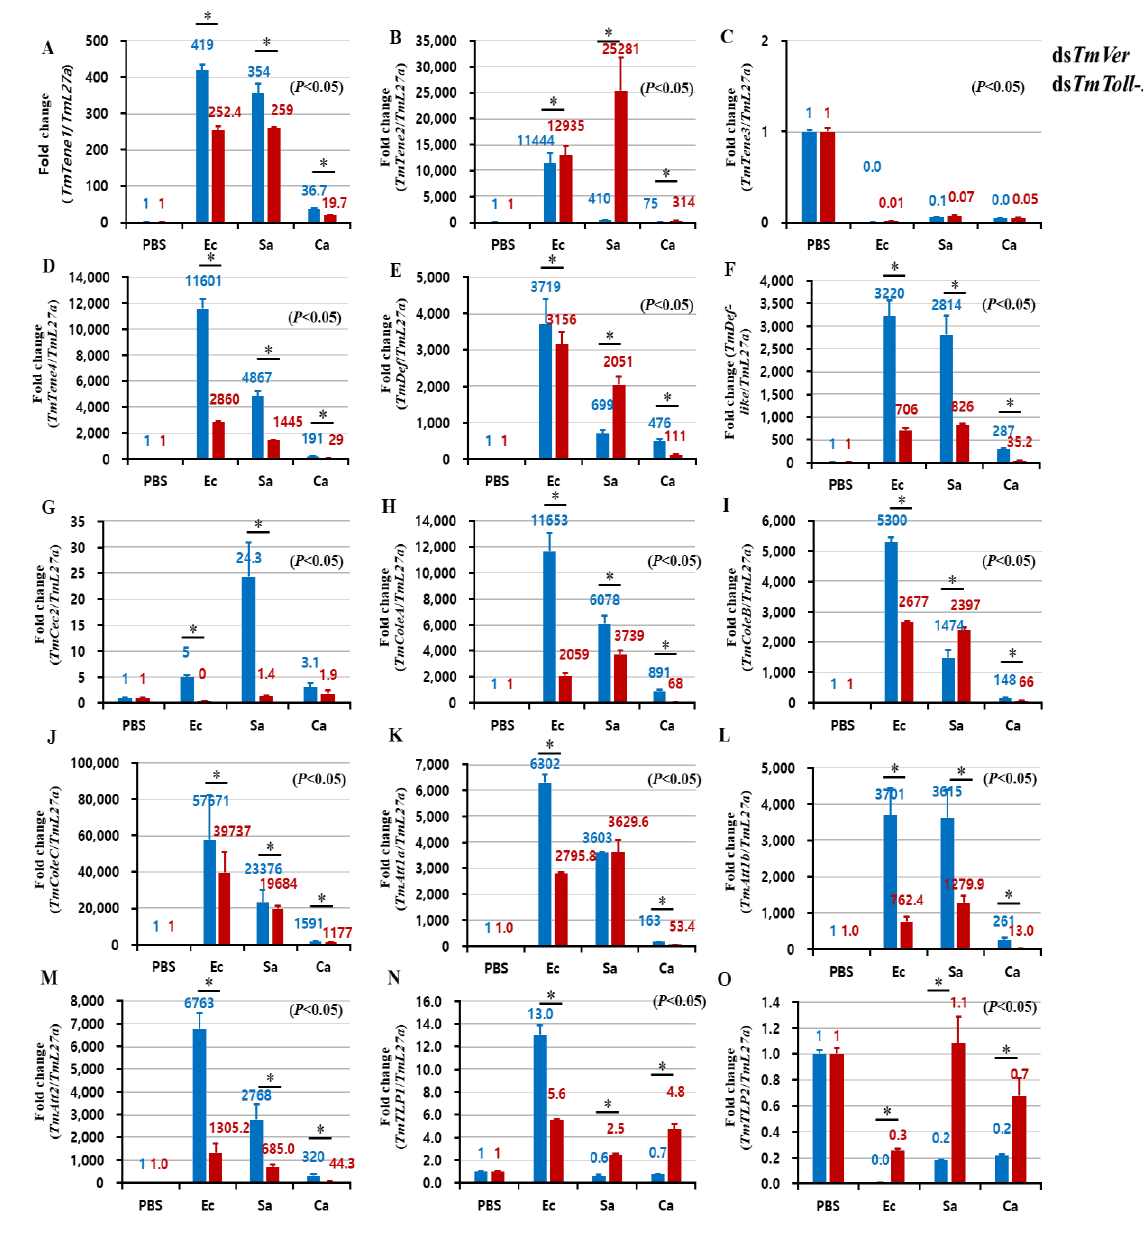
Figure 5. Induction of 15 AMP genes in the whole-body tissues of TmToll-3 -treated T. molitor larvae infected with E. coli (Ec), S. aureus (Sa), and C. albicans (Ca) (PBS was used as a control). At 24 h post-infection, AMP genes including TmTene1 ( A ), TmTene2 ( B ), TmTene3 ( C ), TmTene4 ( D ), TmDef ( E ), TmDef-like ( F ), TmCec2 ( G ), TmColeA ( H ), TmColeB ( I ), TmColeC ( J ), TmAtt1a ( K ), TmAtt1b ( L ), TmAtt2 ( M ), TmTLP1 ( N ), and TmTLP2 ( O ) were examined via qRT-PCR using ds TmVer as a knockdown control and T. molitor ribosomal protein ( TmL27a ) as an internal control. All experiments were performed in triplicate. The asterisks indicate significant differences between the ds TmToll-3 - and ds TmVer -treated groups, as determined by Student’s t -test ( p < 0.05).